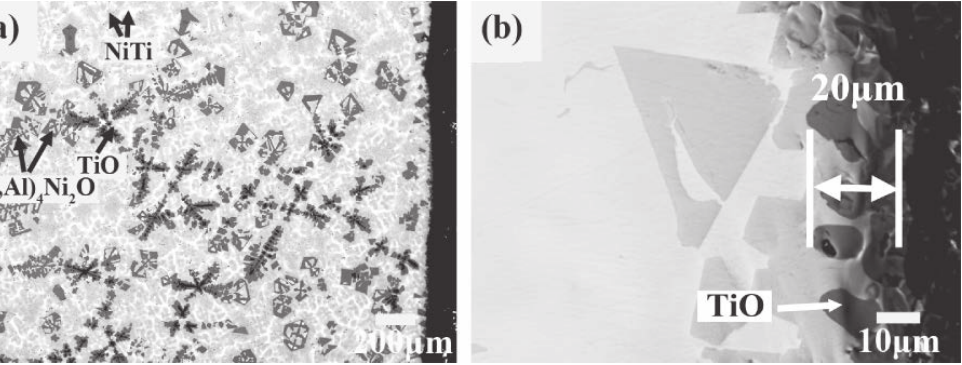
Fig. 4: Metal-crucible interfacial microstructures of the ingot in the case of using Al 2 O 3 crucible at 1550°C (a) and its higher magnification image (b).